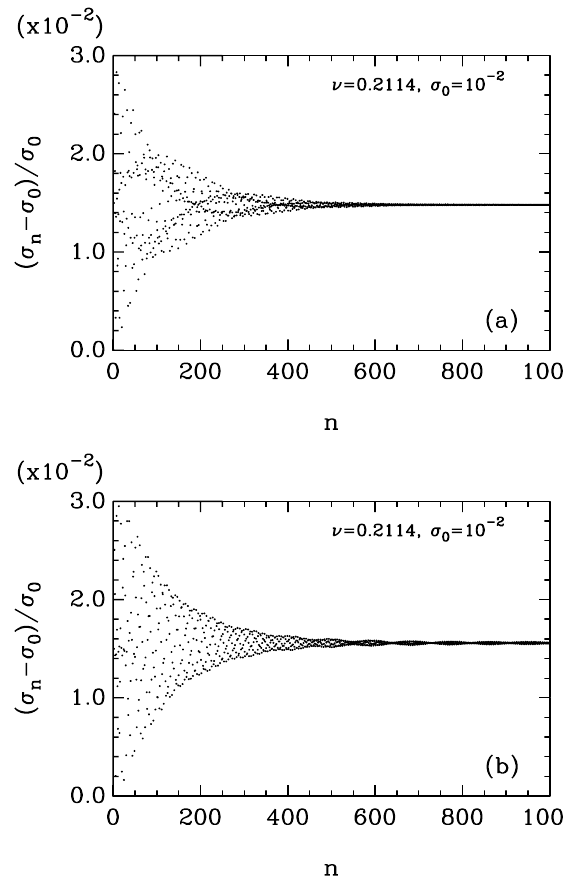
FIG. 1. Evolution of the rms beam emittance of the Hénon map with n (cid:173) (cid:48)(cid:46)(cid:50)(cid:49)(cid:49)(cid:52) calculated by (a) using the moment map (69) and (b) the direct tracking of the phase-space grid points. The initial rms emittance is s (cid:48) (cid:173) (cid:49)(cid:48) 2 (cid:51) , and (cid:110) is the number of turns.